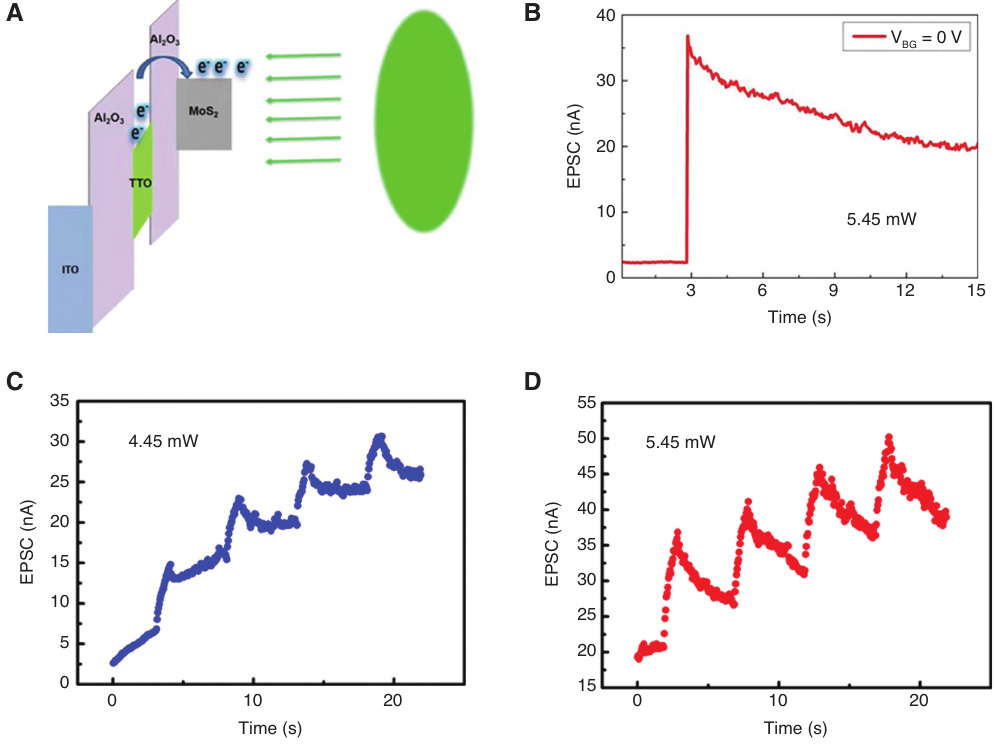
Figure 5: Synaptic performance under laser illumination. (A) Schematic band diagram under laser illumination. (B) EPSC triggered by single laser pulse (5.45 mW, 2 s). (C) EPSC triggered by four consecutive laser pulses (4.45 mW, 2 s, and an interval of 3 s). (D) EPSC triggered by four consecutive laser pulses (5.45 mW, 2 s, and an interval of 3